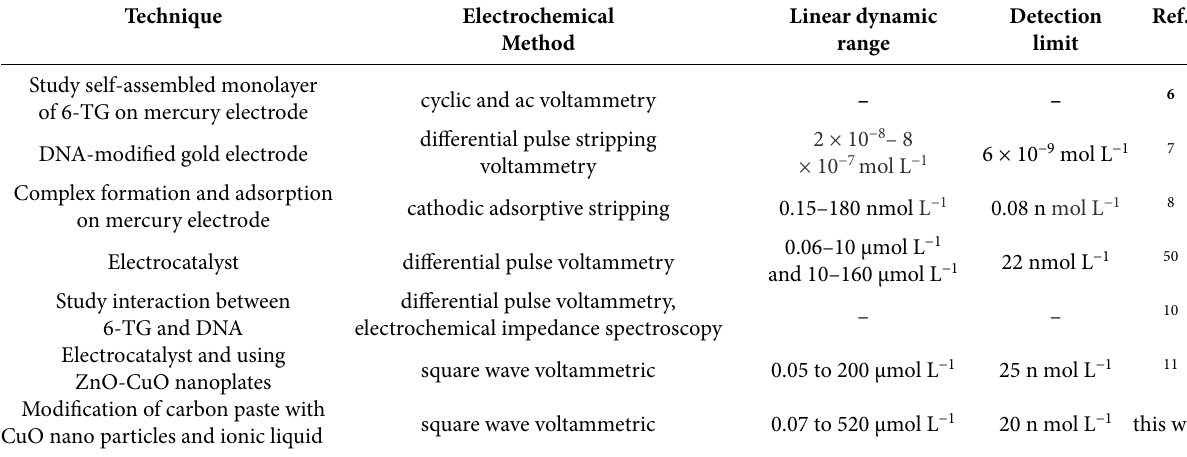
Table 1. Characteristics of several electrochemical methods for determination of 6-TG Technique